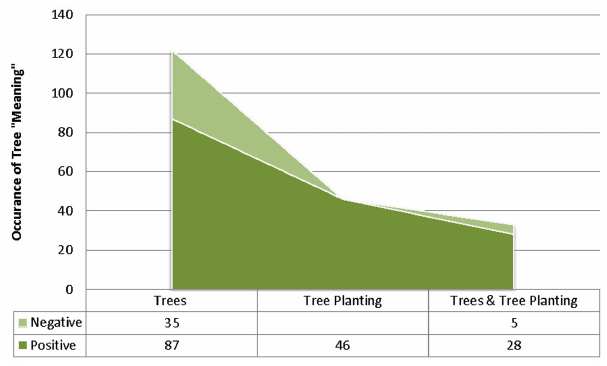
Fig. 5 . Positive and negative symbolic meanings of trees in post-Katrina New